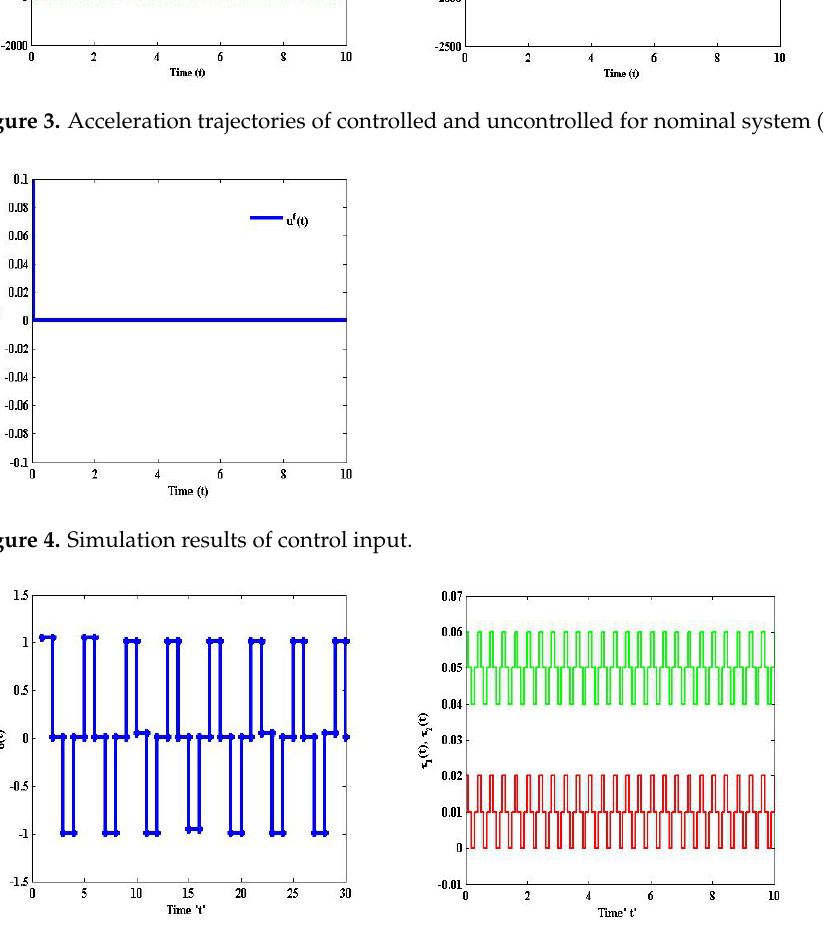
Figure 5. Simulation of random variables δ ( t ) and time varying delays τ 1 ( t ) & τ 2 ( t ) of helicopter system